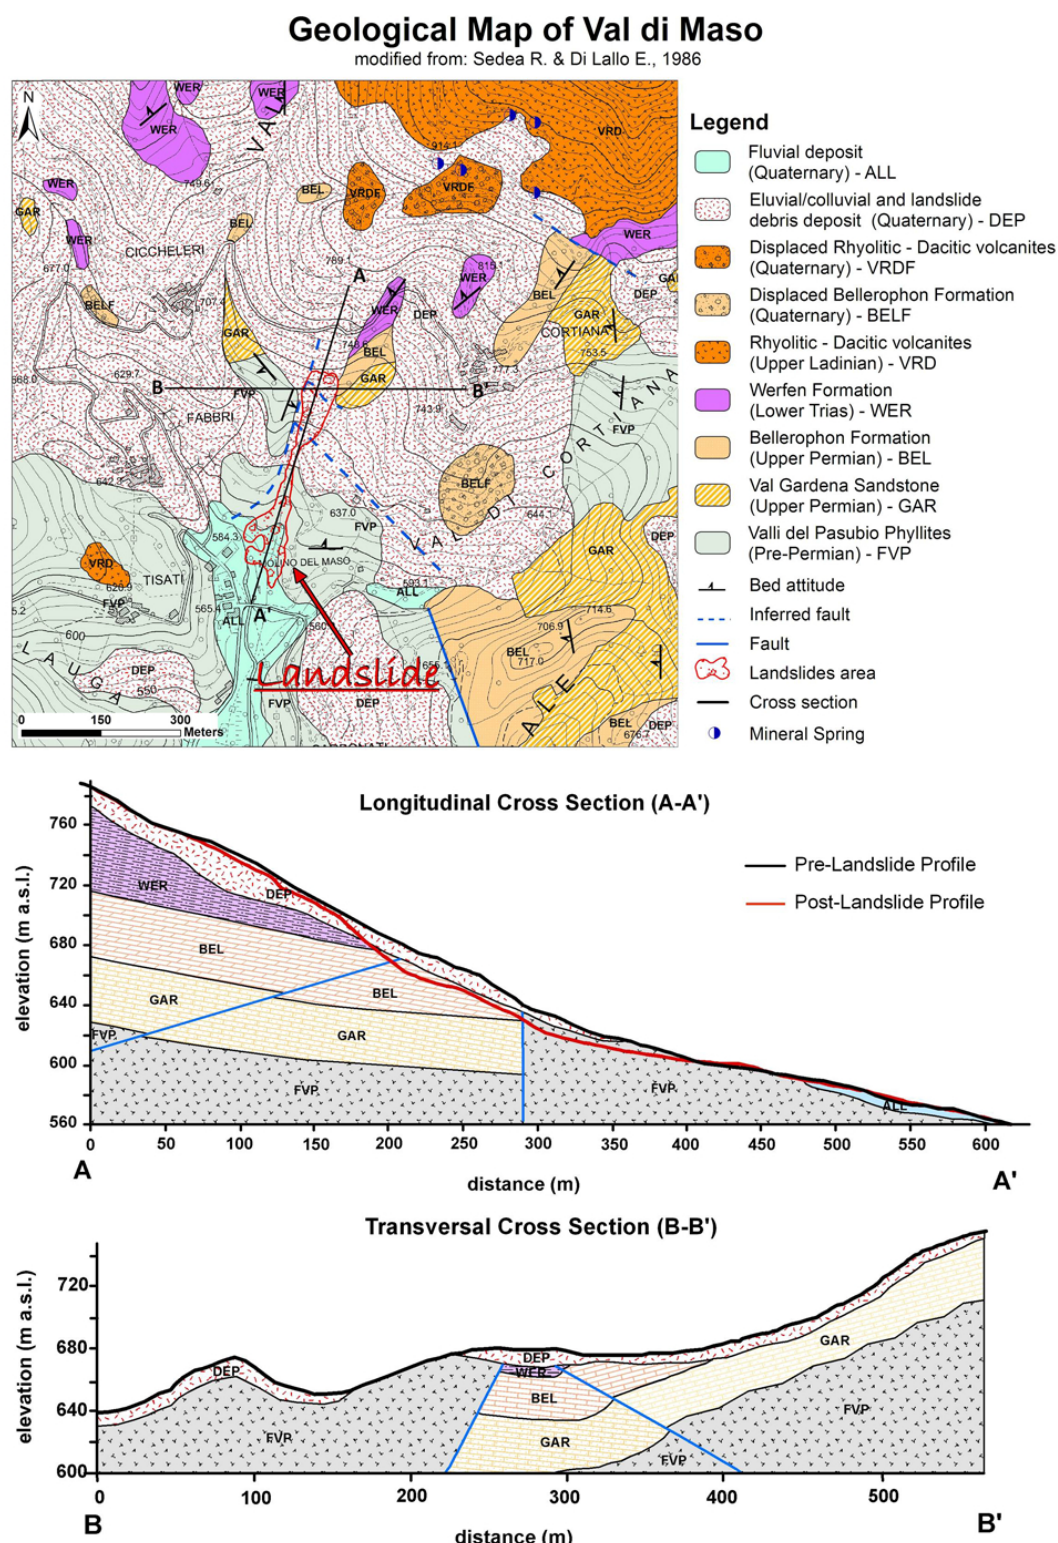
Fig. 5. Geological map of Val di Maso and longitudinal (A–A 0 ) and transversal (B–B 0 ) landslide cross section.